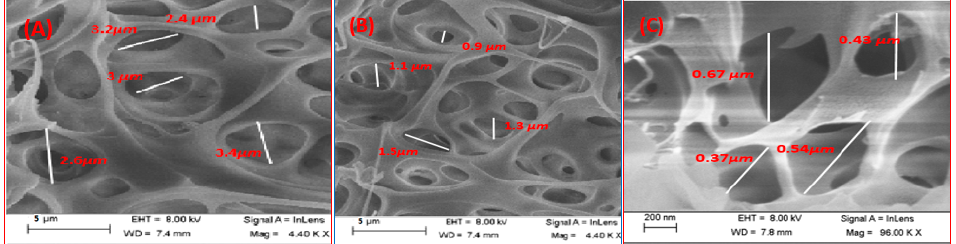
Figure 4. SEM images for ( A ) 0.1 PES/TNR-MWCNT, ( B ) 0.5 PES/TNR-MWCNT, and ( C ) 0.7 PES/TNR-MWCNT membranes with indexed pores diameter for each